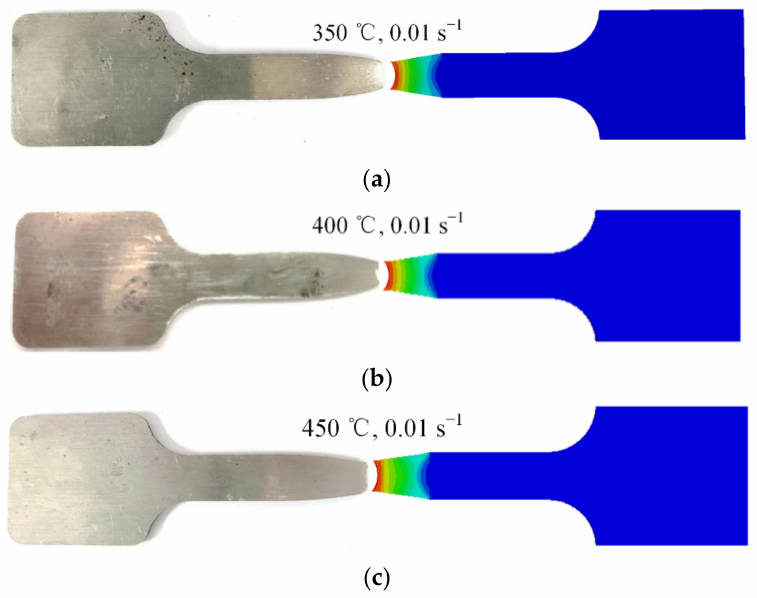
Figure 15. Comparison of specimen geometrical size obtained by simulation and experiment: ( a ) 350 ◦ C, 0.01 s − 1 ; ( b ) 400 ◦ C, 0.01 s − 1 ; ( c ) 450 ◦ C, 0.01 s − 1